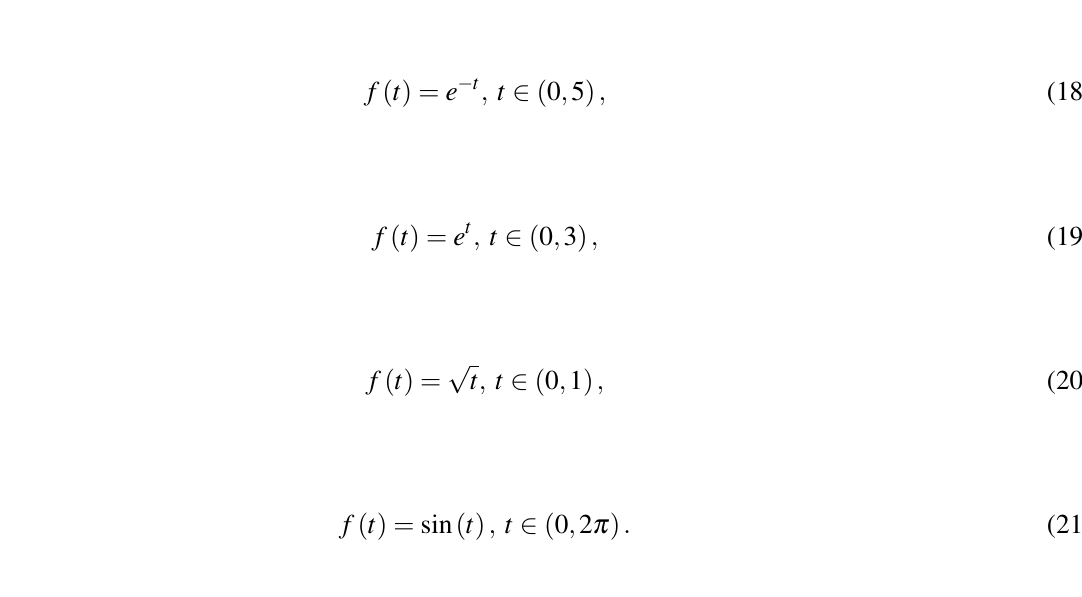
6 Rules of Accuracy Comparison of FOD